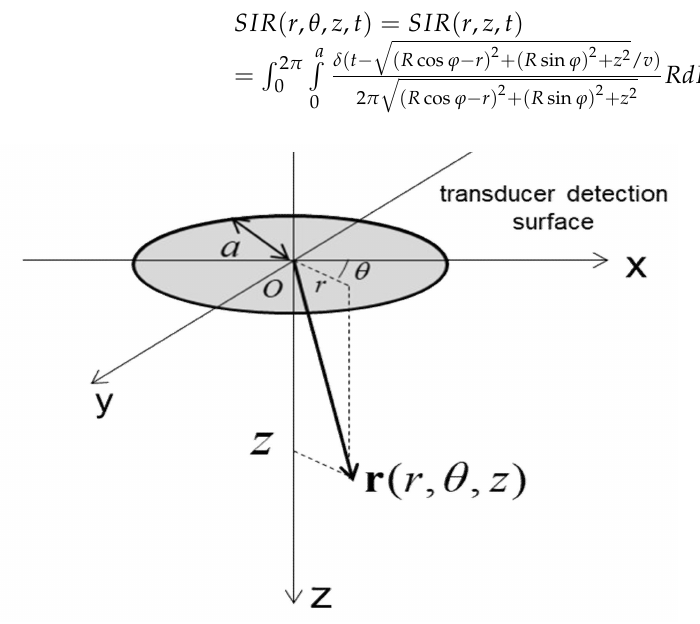
Figure 2. The geometry and notations for the SIR calculation of a circular planar